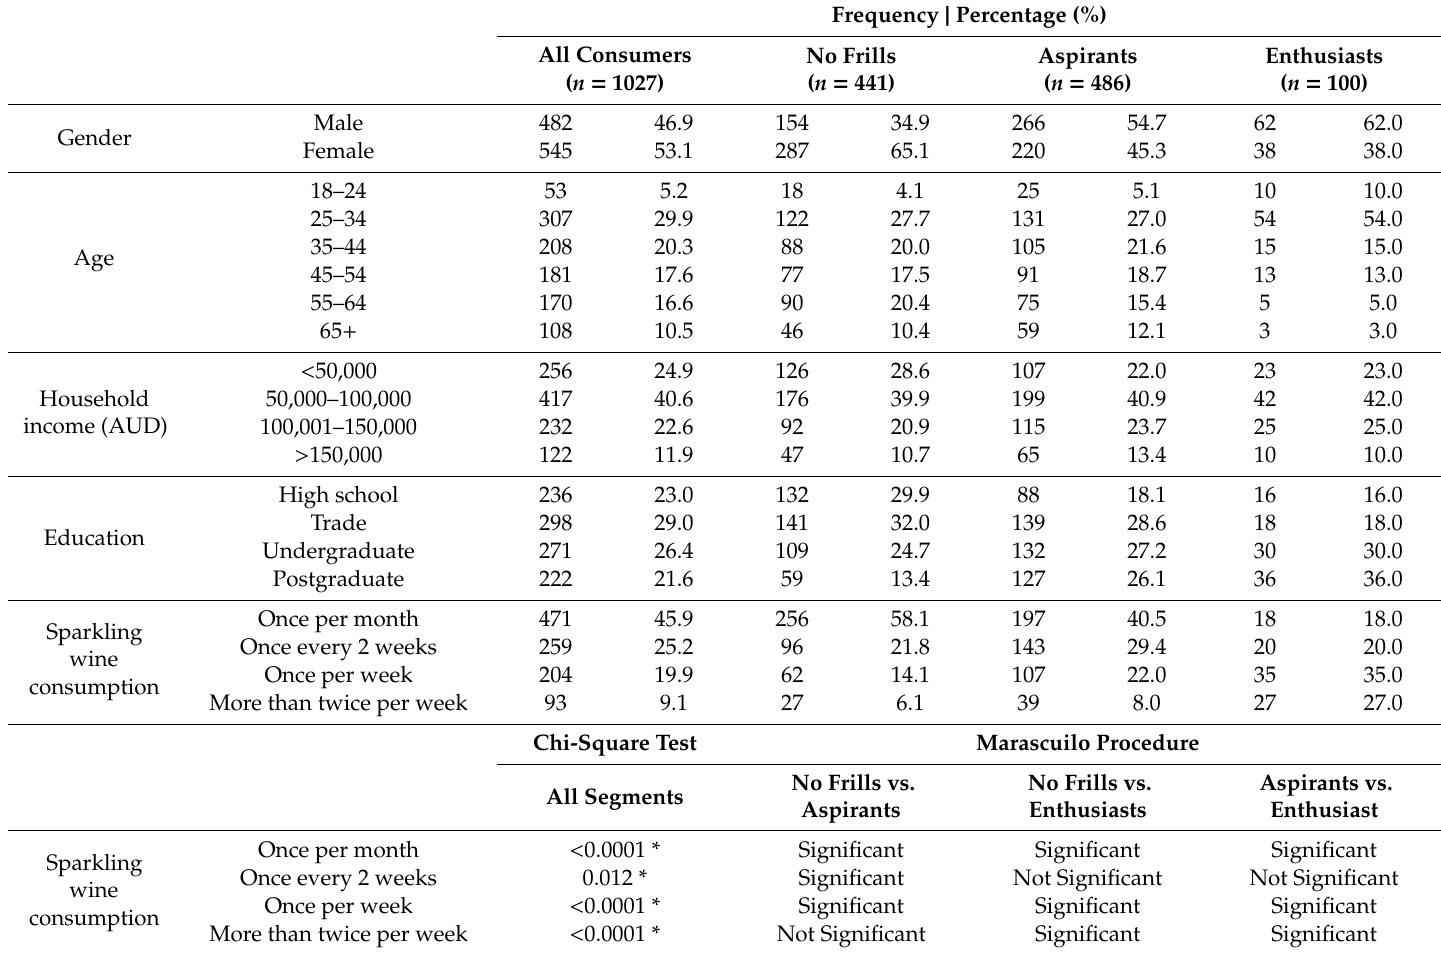
Table 1. Demographics of Fine Wine Instrument consumer segments (data are frequencies and